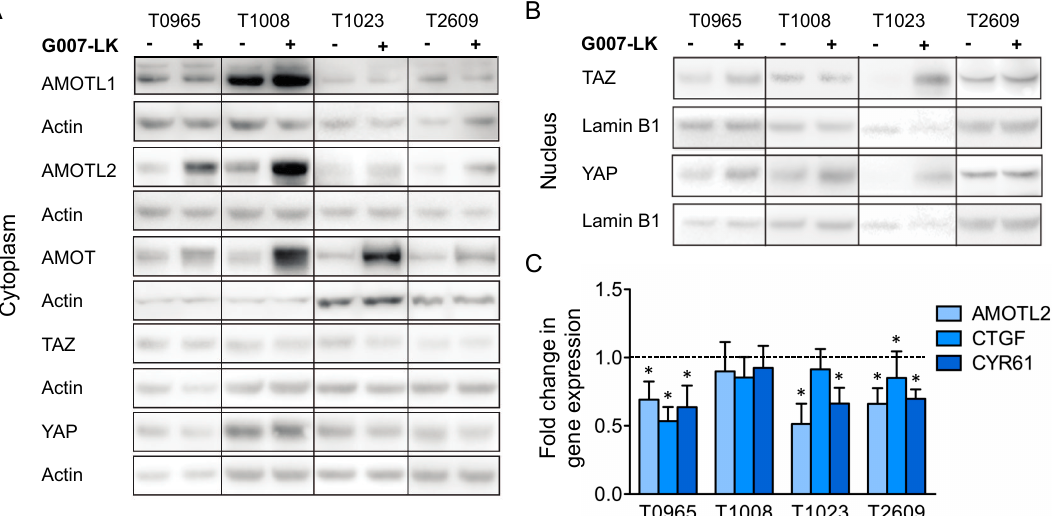
Figure 3. G007-LK stabilizes AMOT / AMOTL2 and reduces the expression of YAP / TAZ target genes. The e ff ect of G007-LK treatment on the ( A ) cytoplasmic and ( B ) nuclear levels of YAP / TAZ signaling proteins; ( C ) Fold changes in gene expression of YAP / TAZ target genes, as assessed by qPCR upon treatment with G007-LK. For both analyses, GSC cultures were treated for 72 h with G007-LK (500 nM) or DMSO (0.01%). Values are relative to those of the DMSO control and are expressed as the fold changes from the DMSO control. The results are presented as the mean ± SD. * p < 0.05.